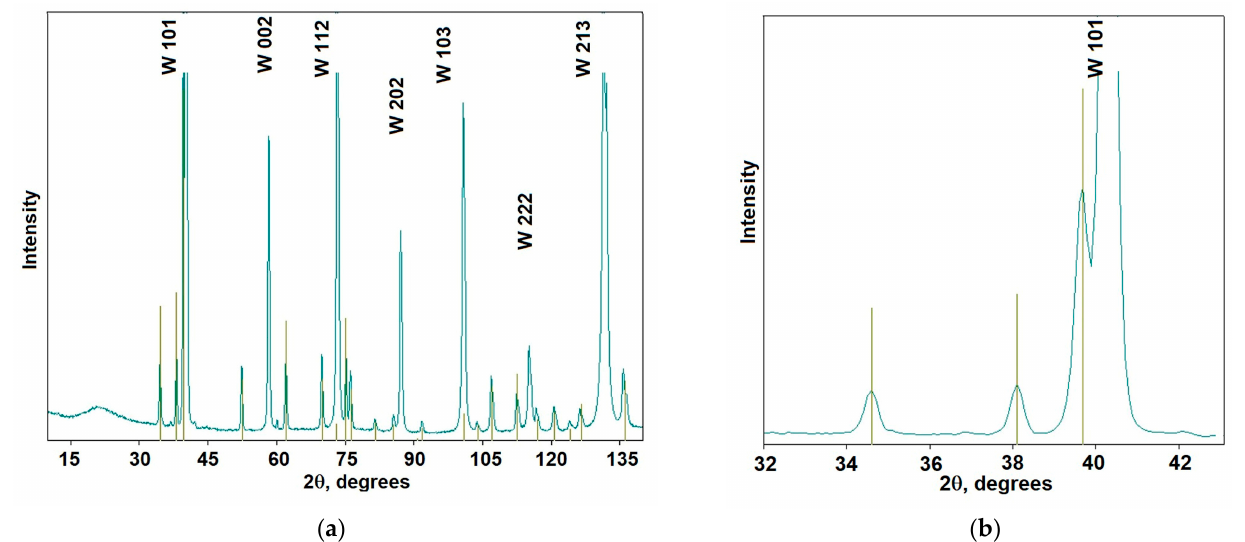
Figure 9. X-ray diffraction pattern of the «tungsten + nanodiamonds» composite after heating up to 1600 °C (tungsten peaks are shown with arrows; the stick diagram shows lines of tungsten carbide W 2 C): ( a ) general view (the amorphous halo is about 22° from the sample holder; ( b ) scaled-up section. This means that oxide WO 2 transformed into oxide WO 3 and has fully sublimated, and carbide WC 0.82 transformed in carbide W 2 C at carbon